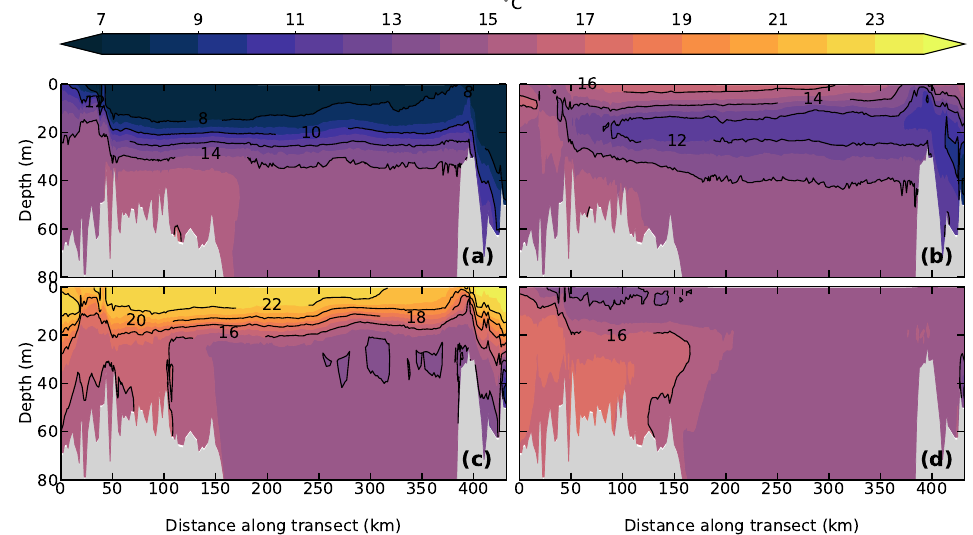
Figure 10. Seasonally-averaged vertical cross section of potential temperature, along a transect in the Dardanelles–Marmara Sea–Bosphorus line. Horizontal axis spanning from the Dardanelles exit at the Aegean to the Bosphorus exit at the Black Sea. ( a ) Winter JFM, ( b ) spring AMJ, ( c ) summer JAS, and ( d ) autumn